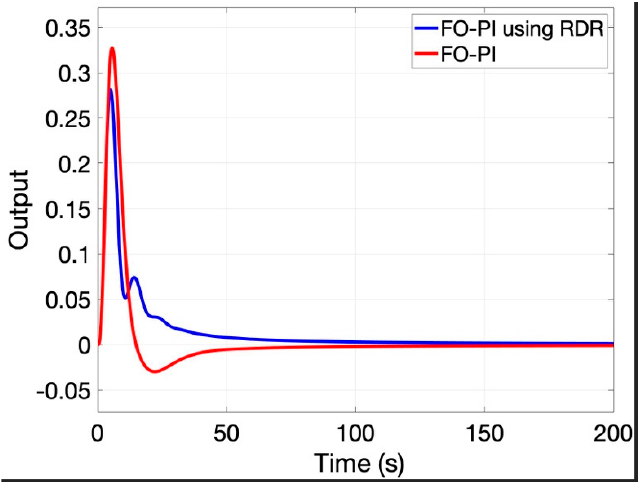
Figure 19. Load disturbance rejection results for a higher-order process (red line – FO-PI designed by Gude 2010) . Gude